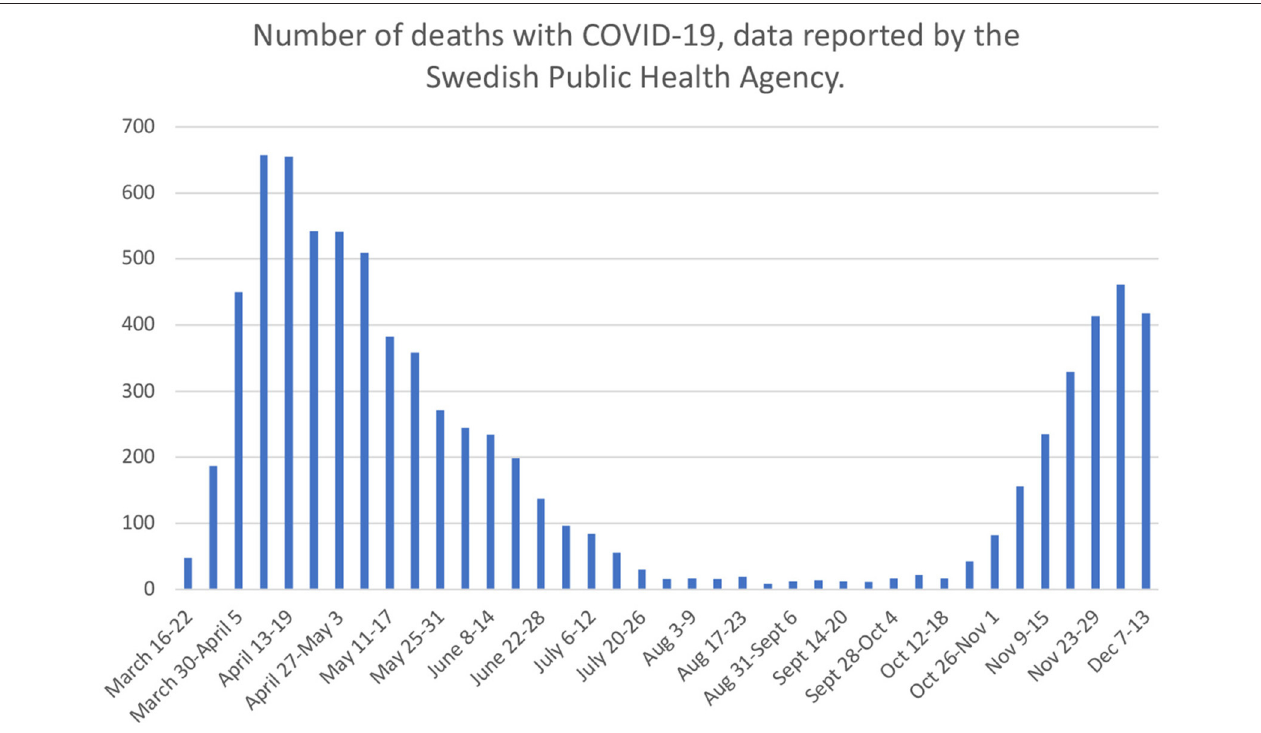
FIGURE 1 | COVID-19 development during 2020. Number of deaths with confirmed COVID-19 infection. Data collected from official statistics of Swedish Public Health Agency (https://www.folkhalsomyndigheten.se/contentassets/4b4dd8c7e15d48d2be744248794d1438/jamforelse-av-olika-matt-pa-covid-19-dodsfall.pdf). Data accessed February 4,